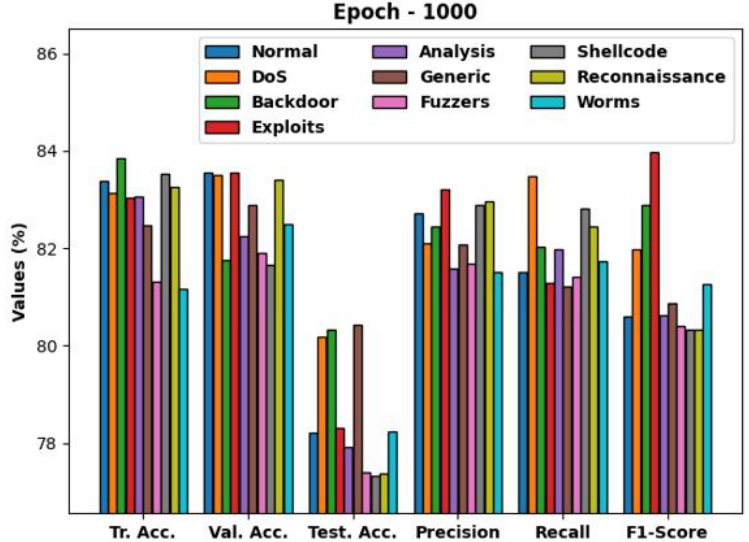
Figure 5. Result analysis of ESOML-IDS technique under 1000 epochs and distinct classes. Table 2. Result analysis of ESOML-IDS technique under 1000 epochs and distinct